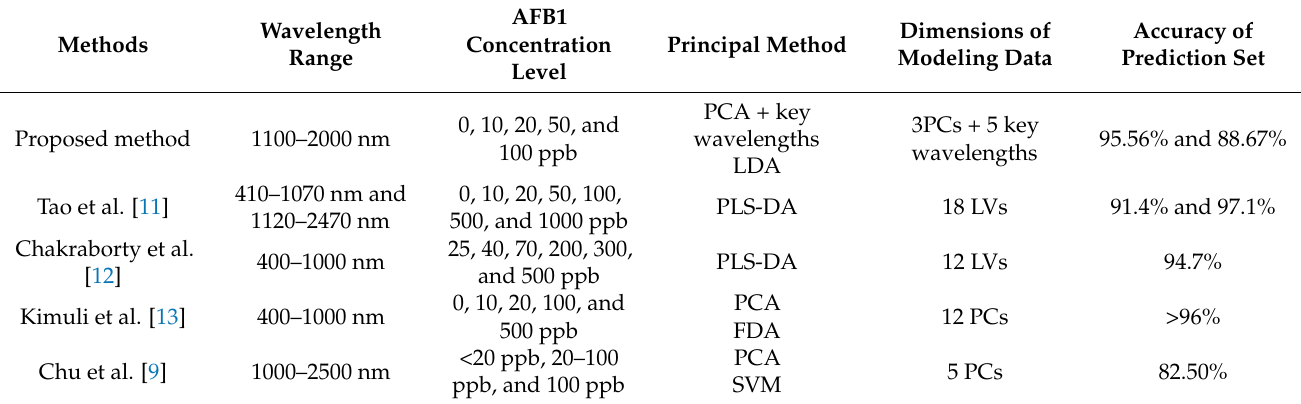
Table 6. Comparison of the results with